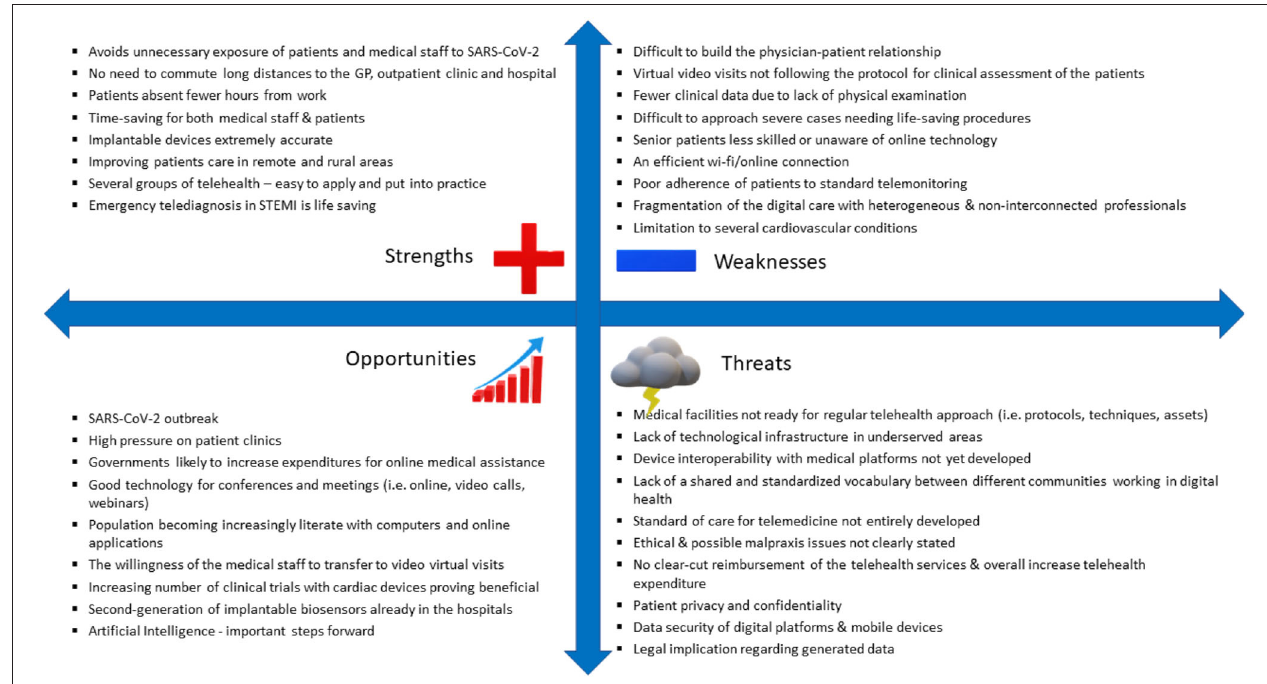
FIGURE 1 | The strengths, weaknesses, opportunities and threats (SWOT analysis) of telemedicine (1–11,